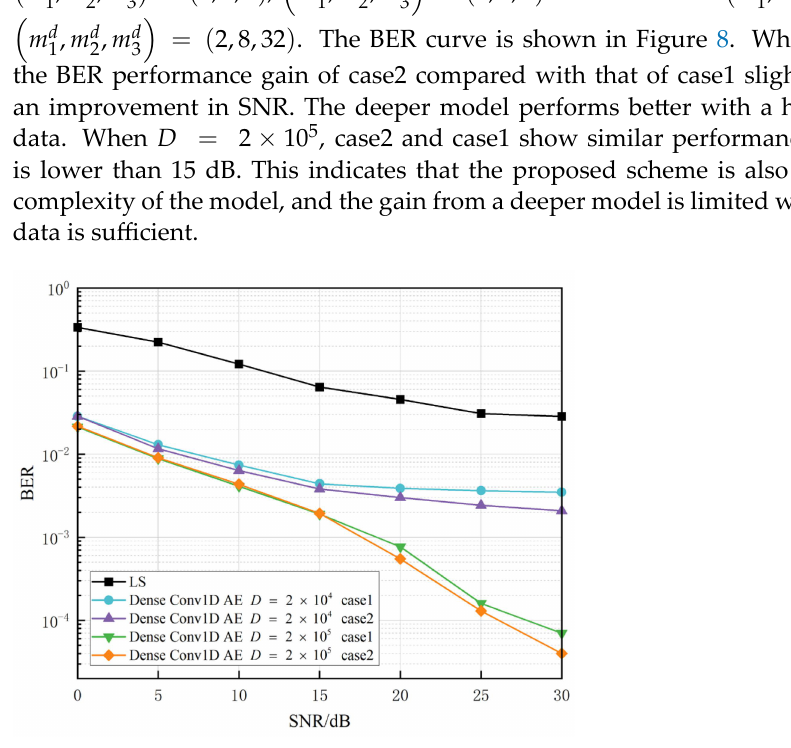
Figure 8. Effect of kernel size on BER